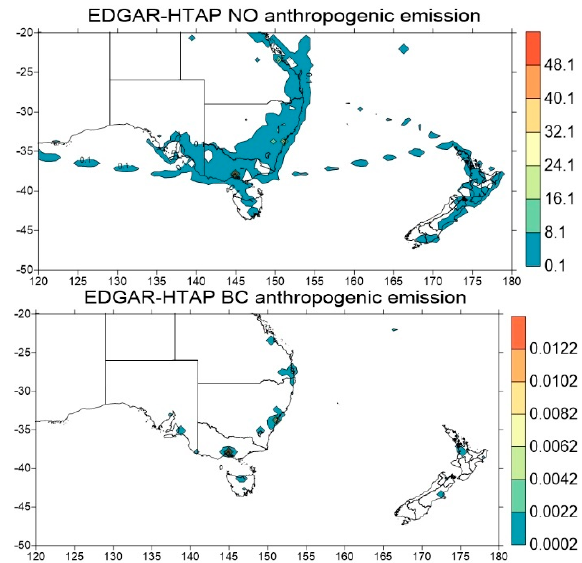
Figure 3. EDGAR-HTAP global anthropogenic emission of nitrogen monoxide (NO) emission (mol km − 2 h − 1 ) and black carbon (BC) emission ( μ g/m 3 m/s) for February 2019. The emission includes land-based and ocean shipping emission.